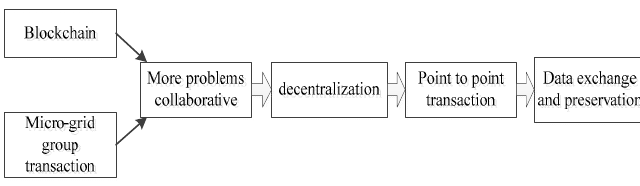
Figure 2. Subject coupling diagram.